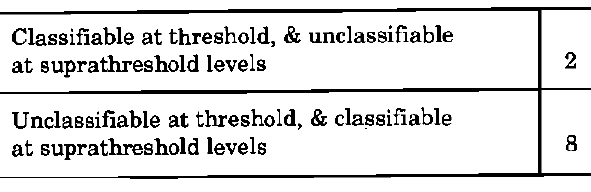
Description and frequency count of